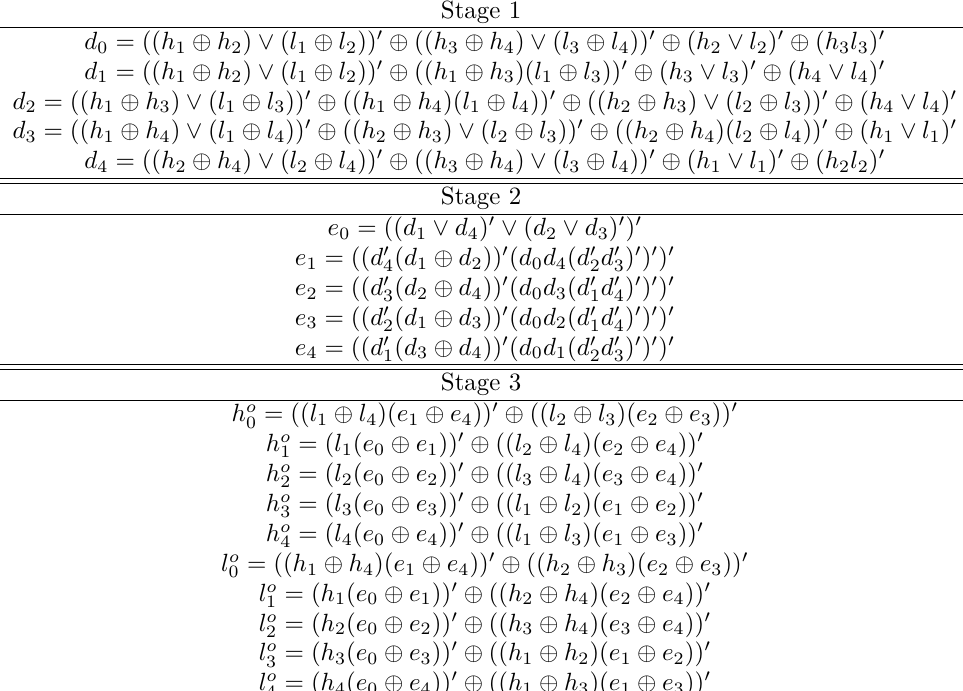
Table 15: Formulations of the improved Ueno S-box (the original S-box is in [UHS + 15]). Stage